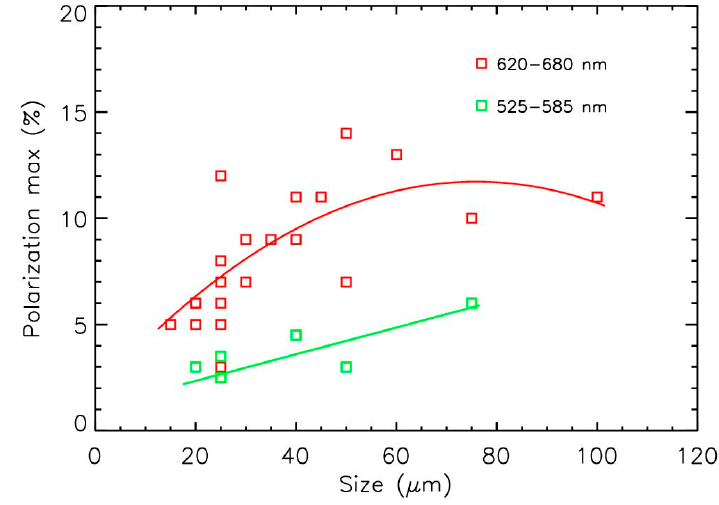
Figure 7. Evolution of the maximum value of polarization with the size of the pollens.